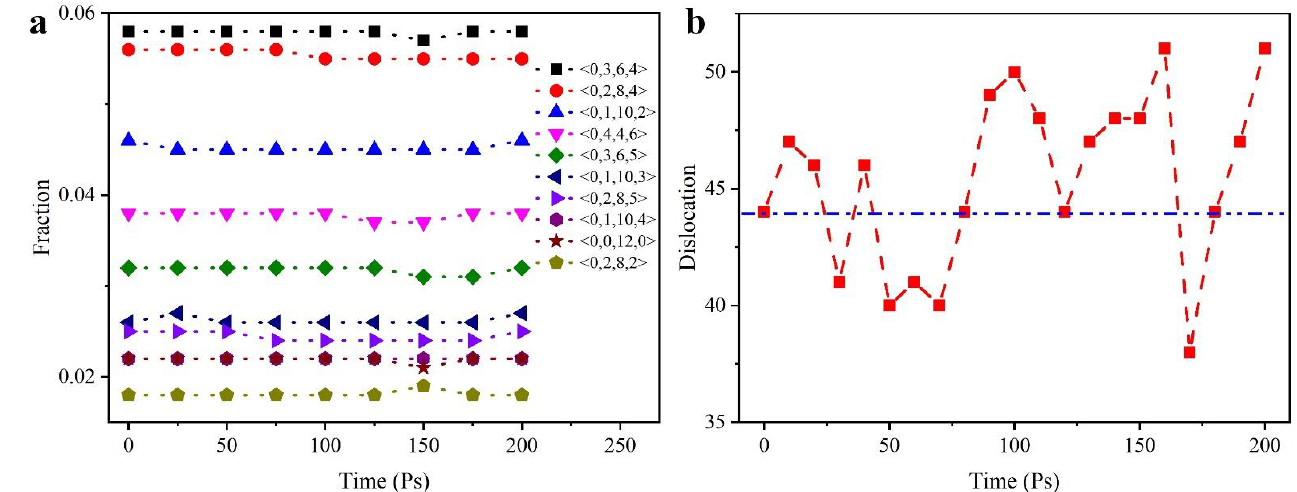
Figure 11. Changes in the internal structure of the model during indentation. ( a ) Voronoi cell statistics at different indent time; ( b ) Dislocation count in XY plane at different indent